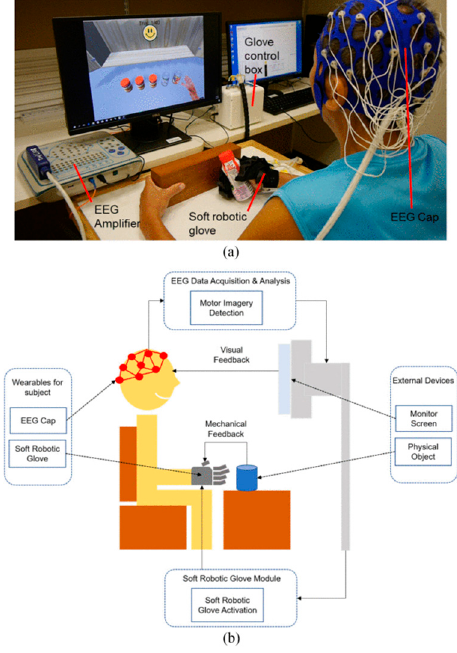
Figure 10. The setup of BCI-assisted soft robotic glove for stroke rehabilitation at ( a ) a local hospi- tal, with ( b )depicting an illustrated overview. The setup comprises a EEG cap, EEG amplifier, and soft robotic glove. Adapted with permission from Ref. [101]. 2022, Cheng N et al.